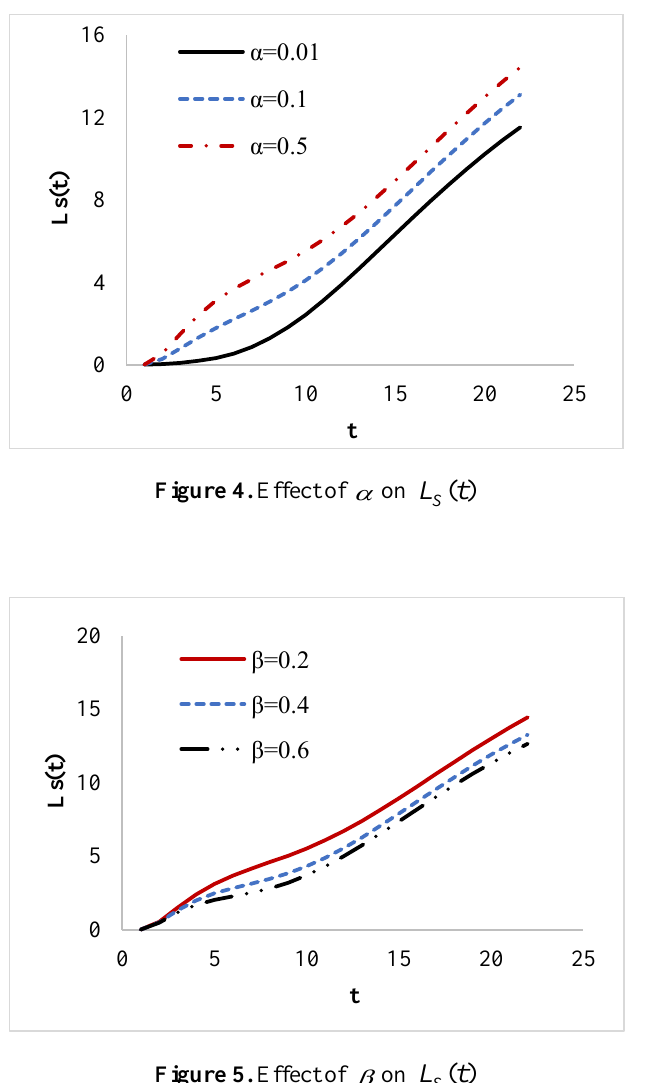
Figure 5. Effect of 